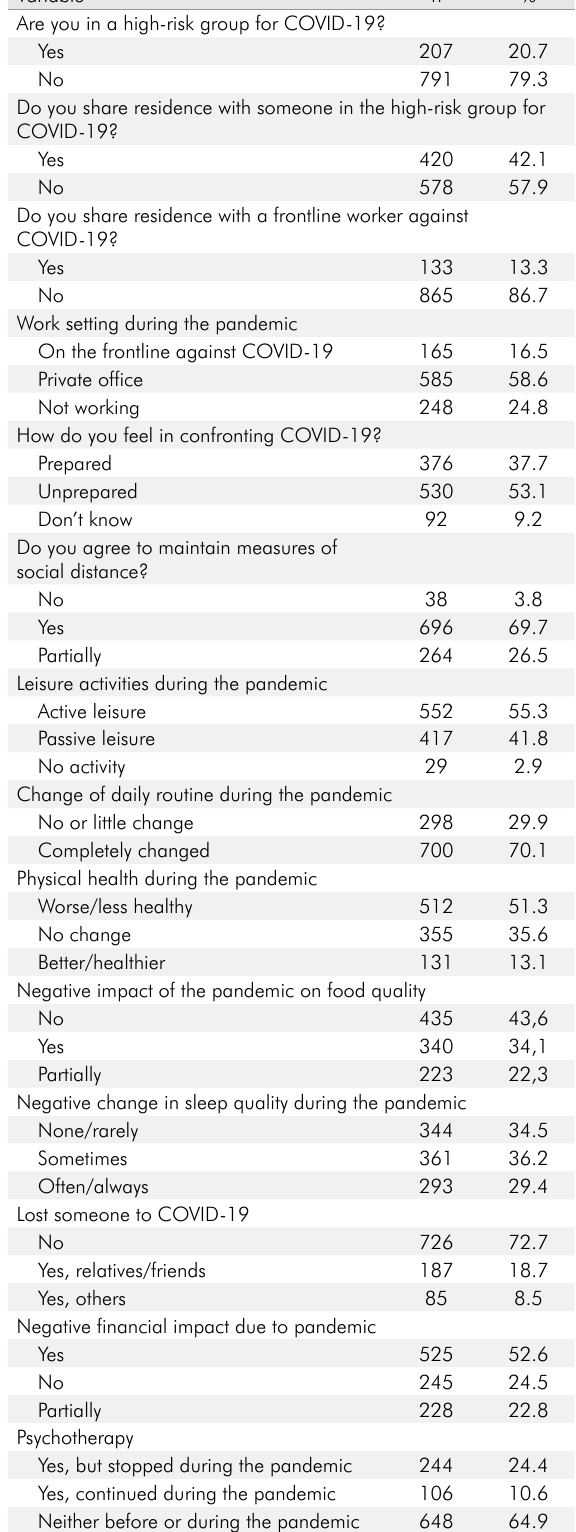
Table 1. Sociodemographic and professional characteristics of the sample.